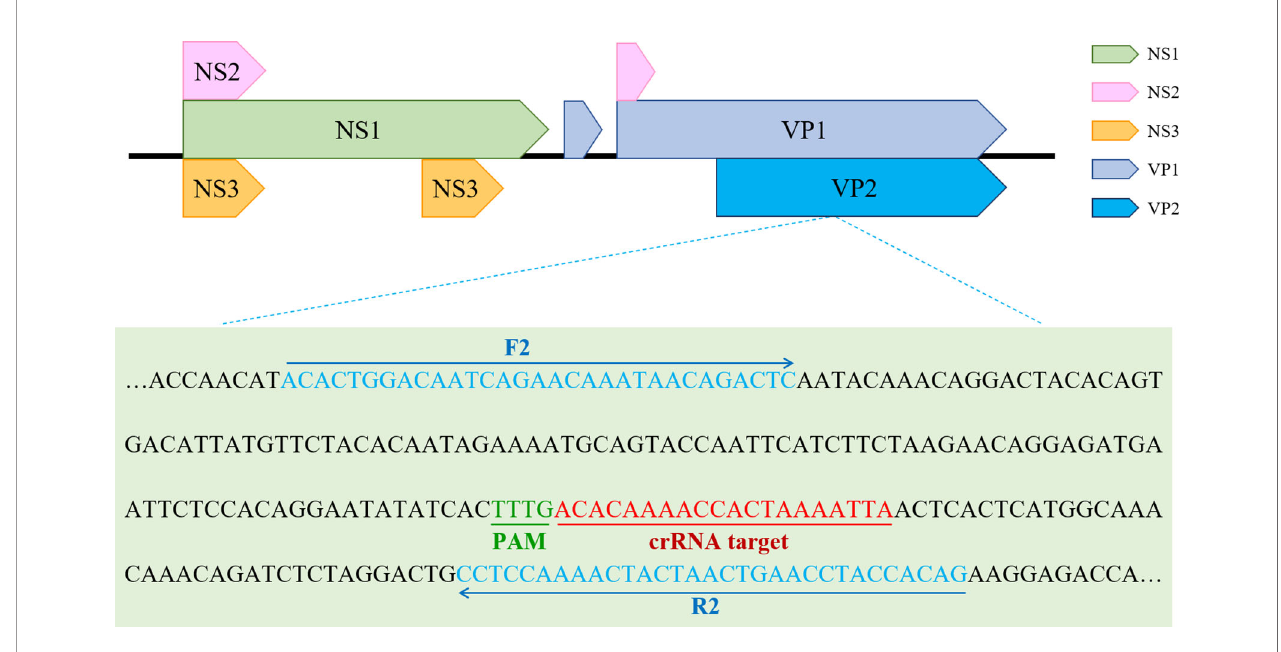
FIGURE 2 | The optimal primer pairs for ERA and crRNA binding sites in the target VP2 gene sequence of PPV.